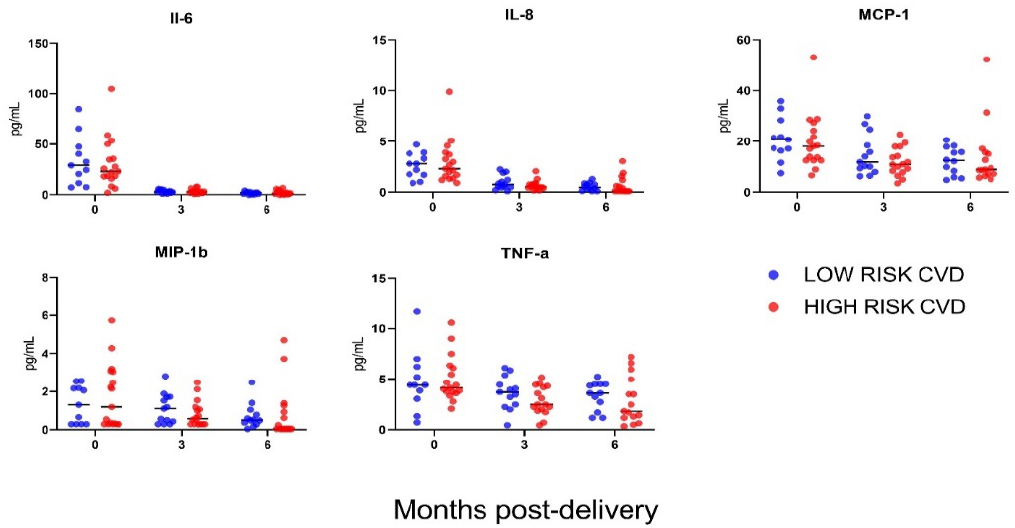
Figure 3. Maternal serum cytokine profiles. Cytokine data are stratified by participant lifetime CVD risk status at 6-months postpartum (low versus high). Sample sizes at each time point: n = 28 at delivery, n = 29 at 3-months postpartum and n = 27 at 6-months postpartum.